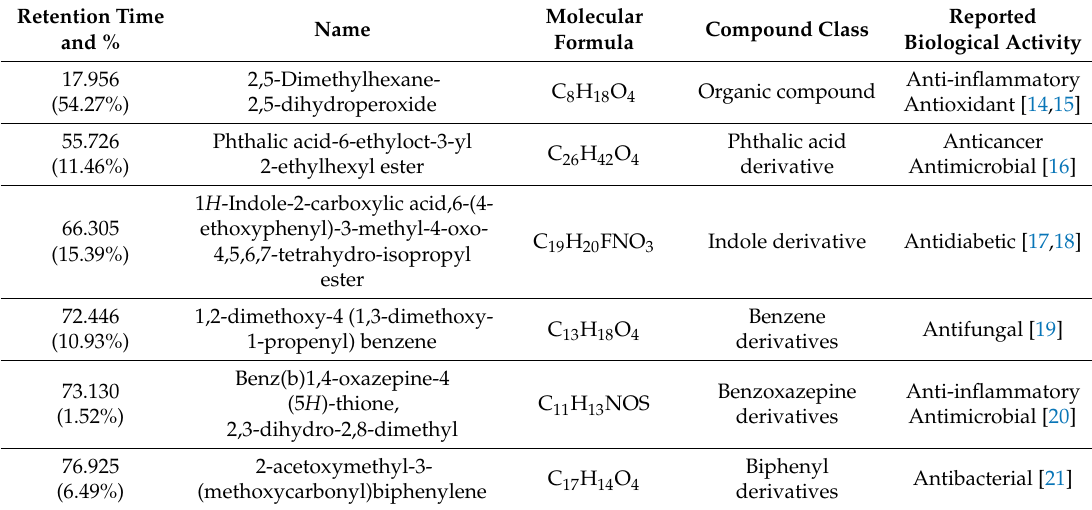
Table 4. Active compounds identified in the ethyl acetate fraction of G. edulis by gas chromatography-mass spectrometry (GC-MS)